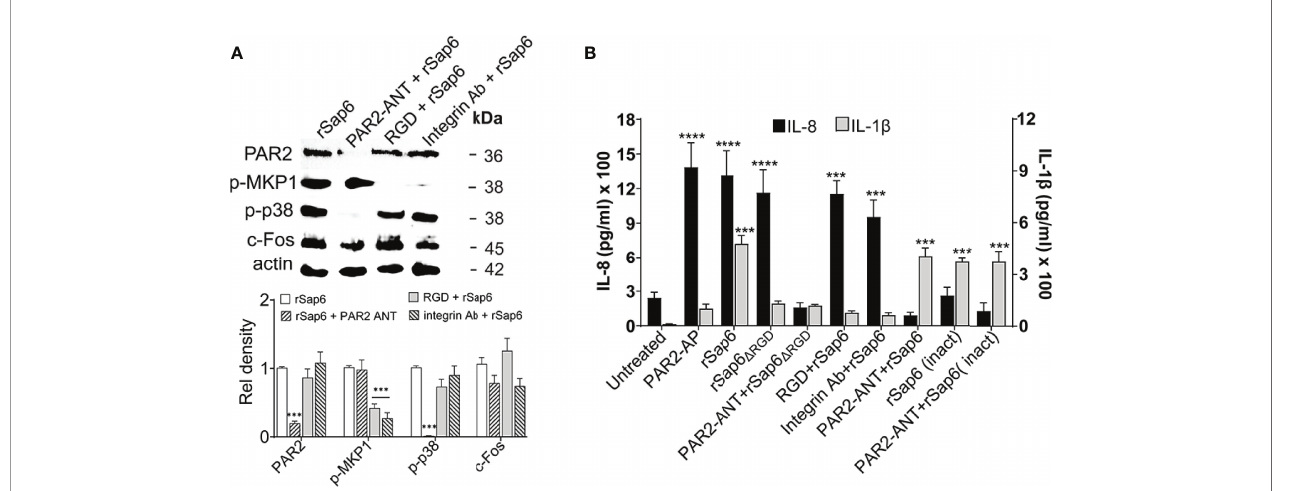
FIGURE 5 | Sap6 RGD domain is required for IL-1 b release independent of PAR2 activation while IL-8 release is PAR2 dependent. OECs were treated with rSap6, rSap6 D RGD or rSap6 (Inact) (all at 10µM) or pretreated with PAR2-ANT (100µM), RGD peptide (10µM) or ant-integrin Ab (1:100) for 3 h (for MAPK signaling) or 24 h (for cytokine release in culture supernatants). (A) Immunoblotting and densitometry showed that pretreatment with PAR2-ANT signi fi cantly reduced rSap6 induced PAR2 levels and p38 phosphorylation, while pretreatment with either RGD peptide or anti-integrin Ab blocked Sap6 induced MKP1 phosphorylation without affecting p38 phosphorylation or PAR2 levels. (B) IL-1 b (grey bars) and IL-8 (black bars) cytokine levels were measured by ELISA. OECs pretreated with RGD peptide or anti-integrin Ab prior to Sap6 stimulation resulted in an approximately six-fold reduction in IL-1 b , similar to that induced by rSap6 D RGD , while addition of Sap6 (Inact) or pretreatment with PAR2-ANT resulted in equivalent production of rSap6. OECs pretreated with PAR2-ANT or with Sap6 (Inact) resulted in 10 fold reduction in IL-8 while pretreatment with RGD peptide or anti- integrin Ab prior to Sap6 stimulation did not alter IL-8 release. Data are mean ± SEM of three independent experiments. P values are p ≤ 0.001 (***) and p ≤ 0.00001